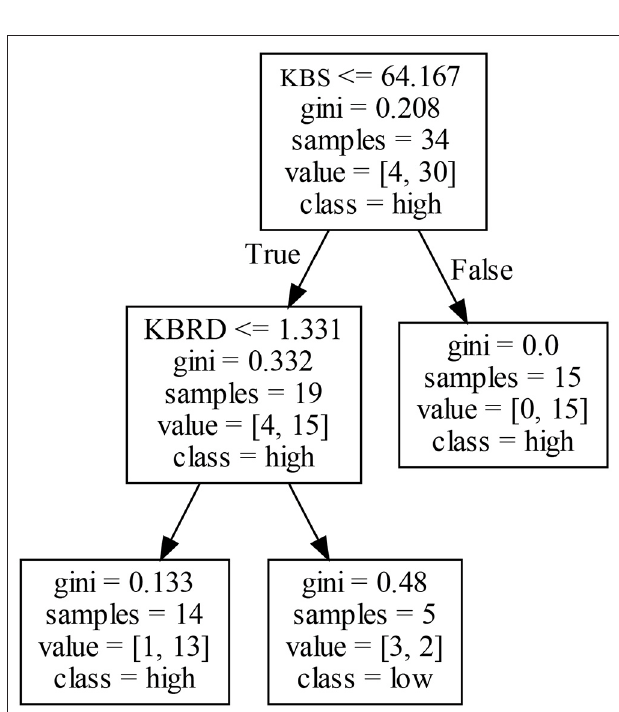
FIGURE 5 | Decision tree for EIP1 in Cluster